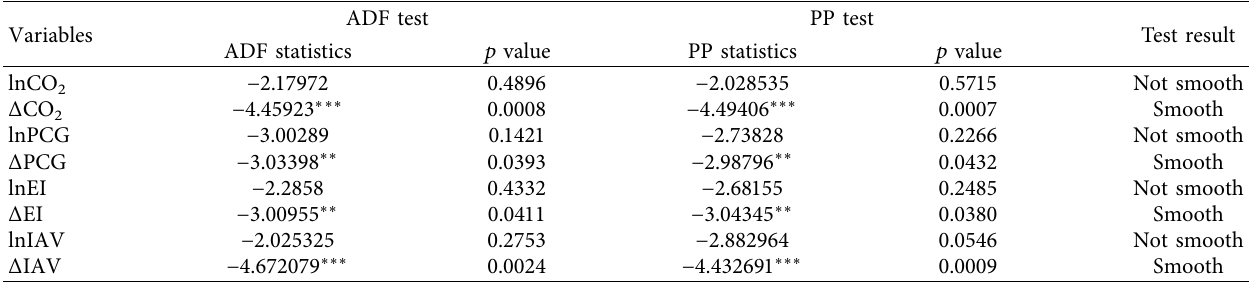
Figure 3: Three periods of China ʼ s carbon emissions over the years. Table 4: ADF unit root test.